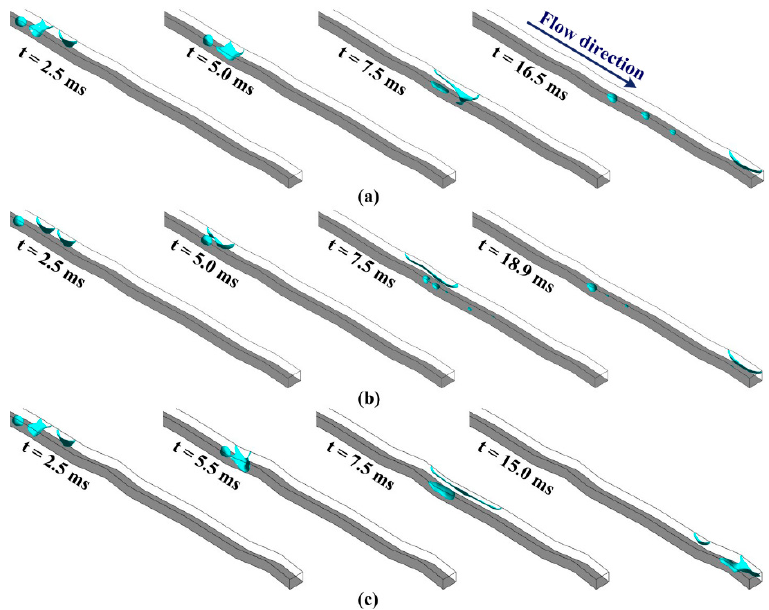
Figure 13. Temporal droplet flow for multiple droplets of different sizes (r = 200 μ m, 250 μ m and 250 μ m) in ( a ) Design 1; ( b ) Design 2; ( c ) Design 3 channels at an inlet velocity of 10 ms − 1 and contact angle θ GDL = 120°, θ side; top = 82°; 82°, respectively.